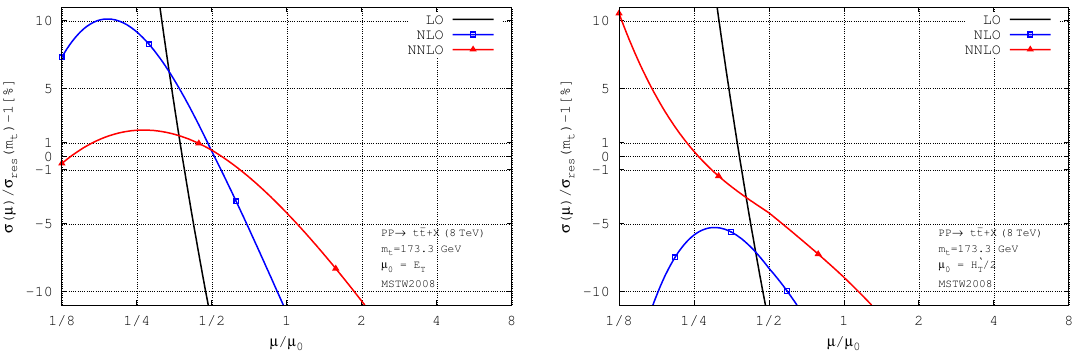
Figure 3 . As in (cid:12)gure 2 but for scale E T (3.5) (left) and H 0 MSTW2008. The symbols on some of the lines are meant to help distinguish the various